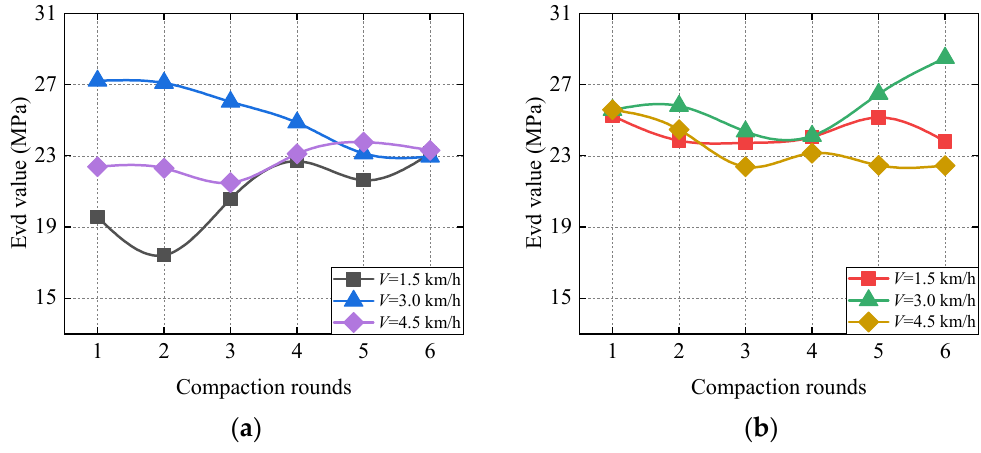
Figure 14. Curve of average E vd under different rounds of compaction. ( a ) Strong excitation. ( b ) Weak excitation.